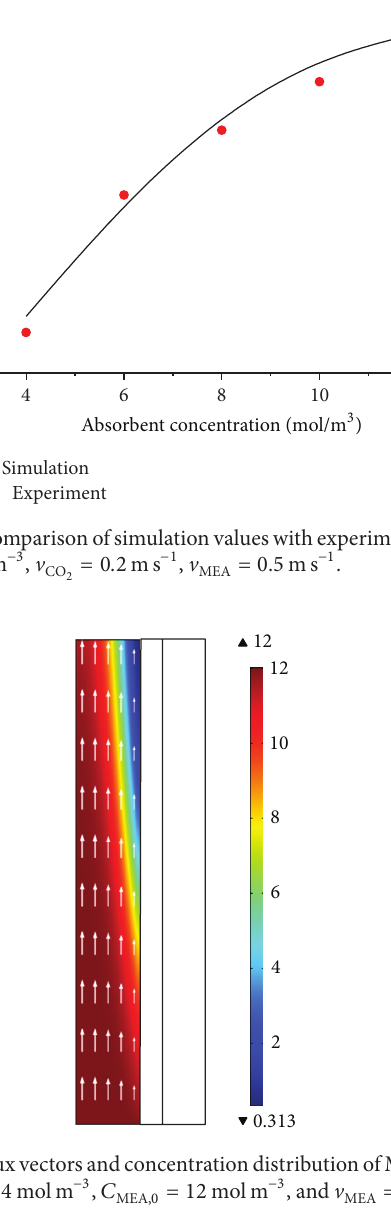
= 12 mol m −3 , and V = 0.5 ms −1 . MEA ,0 MEA